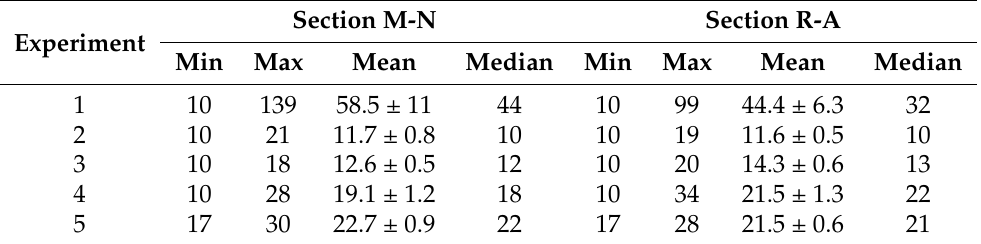
Table 6. Concentration of exhaust gases (in ppm) during a given experiment, in sections M-N and